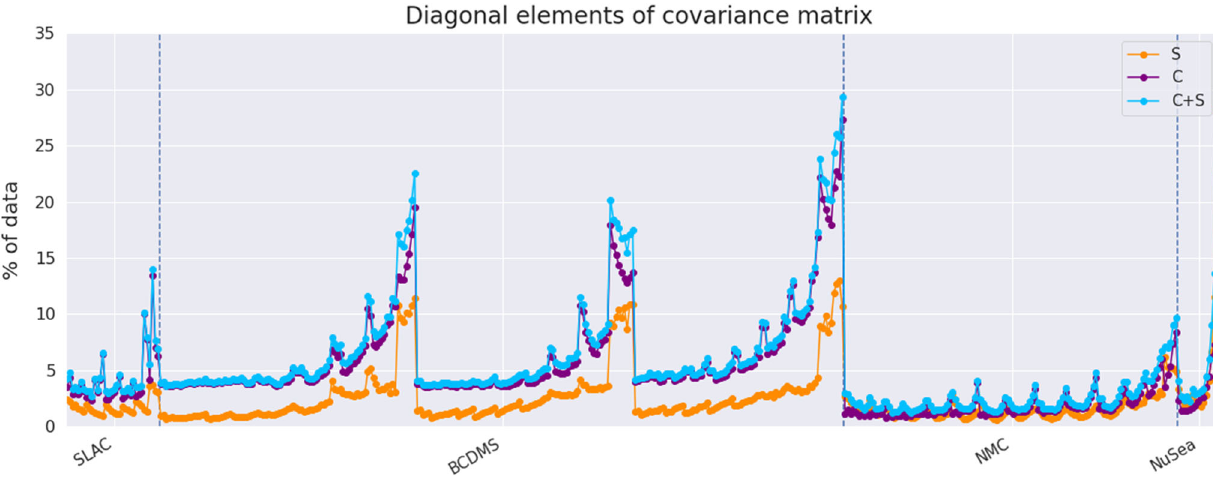
Fig. 3 The square root of the diagonal elements of the covari- ance matrices normalised to the experimental data, for the deuteron measurements from SLAC, BCDMS, NMC and